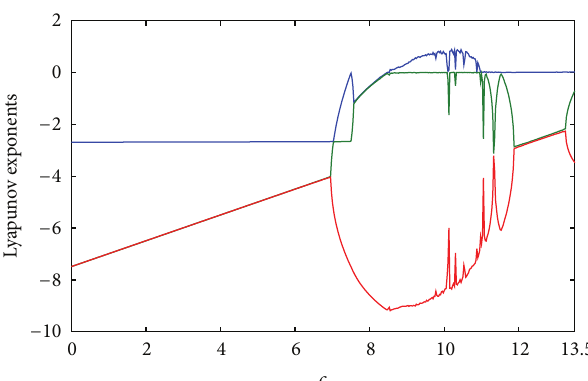
Figure 7: Lyapunov exponents spectrum of the system with respect to 𝑐 .